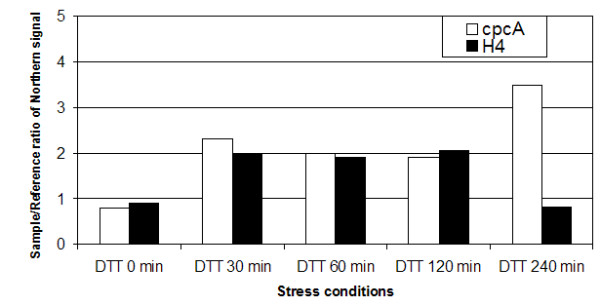
Northern analysis of A. nidulans cpcA and histone H4 genes in a culture treated with DTT and in an untreated reference culture. The expression level of the genes was analysed in a culture treated with DTT for 0, 30, 60, 120 and 240 min and in untreated reference culture. The signals of the specific mRNAs were quantified and normalised using the signals of gpd1. The ratio of the signal in the analysed sample vs. the signal in a corresponding reference culture are shown. cpcA [70], H4 [30].